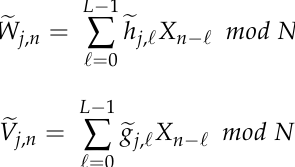
where (cid:96) = 0, . . . , L − 1 and L represents the filter length. The subscript j is the level to which the signal will be